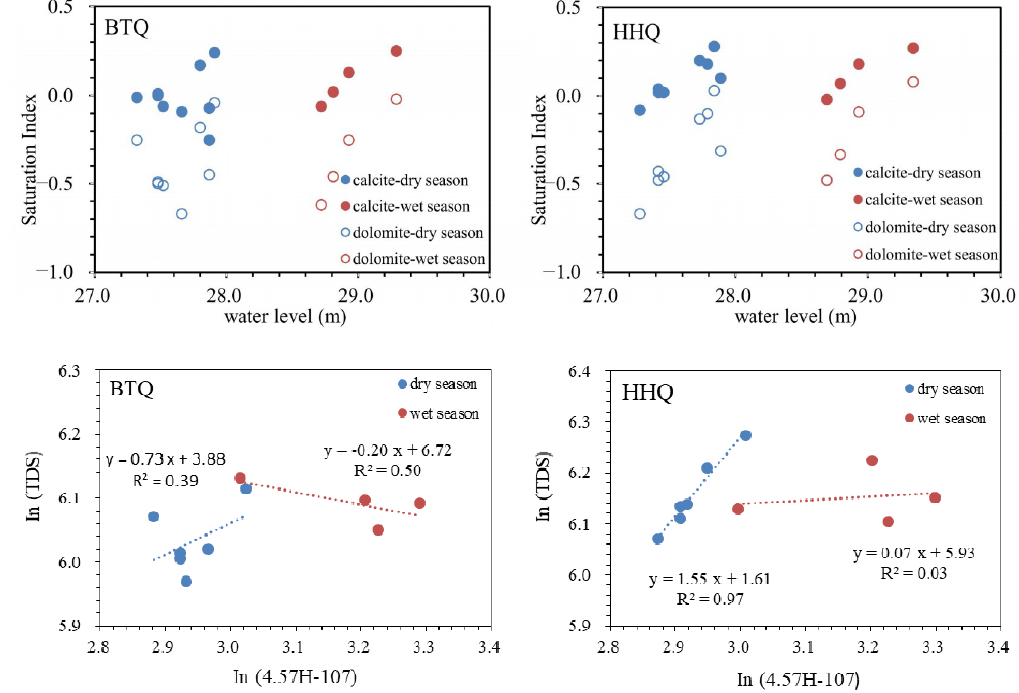
Figure 8. The relationship between water level and saturation index of calcite and dolomite and the relationship between and water level with TDS (total dissolved solutions) in BTQ and HHQ.